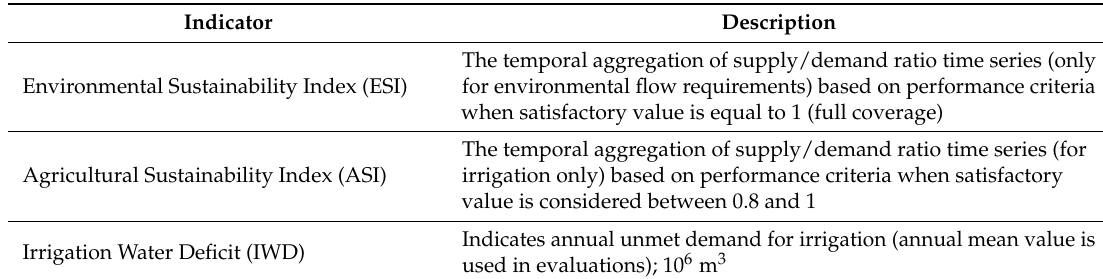
Table 2. Evaluation indicator